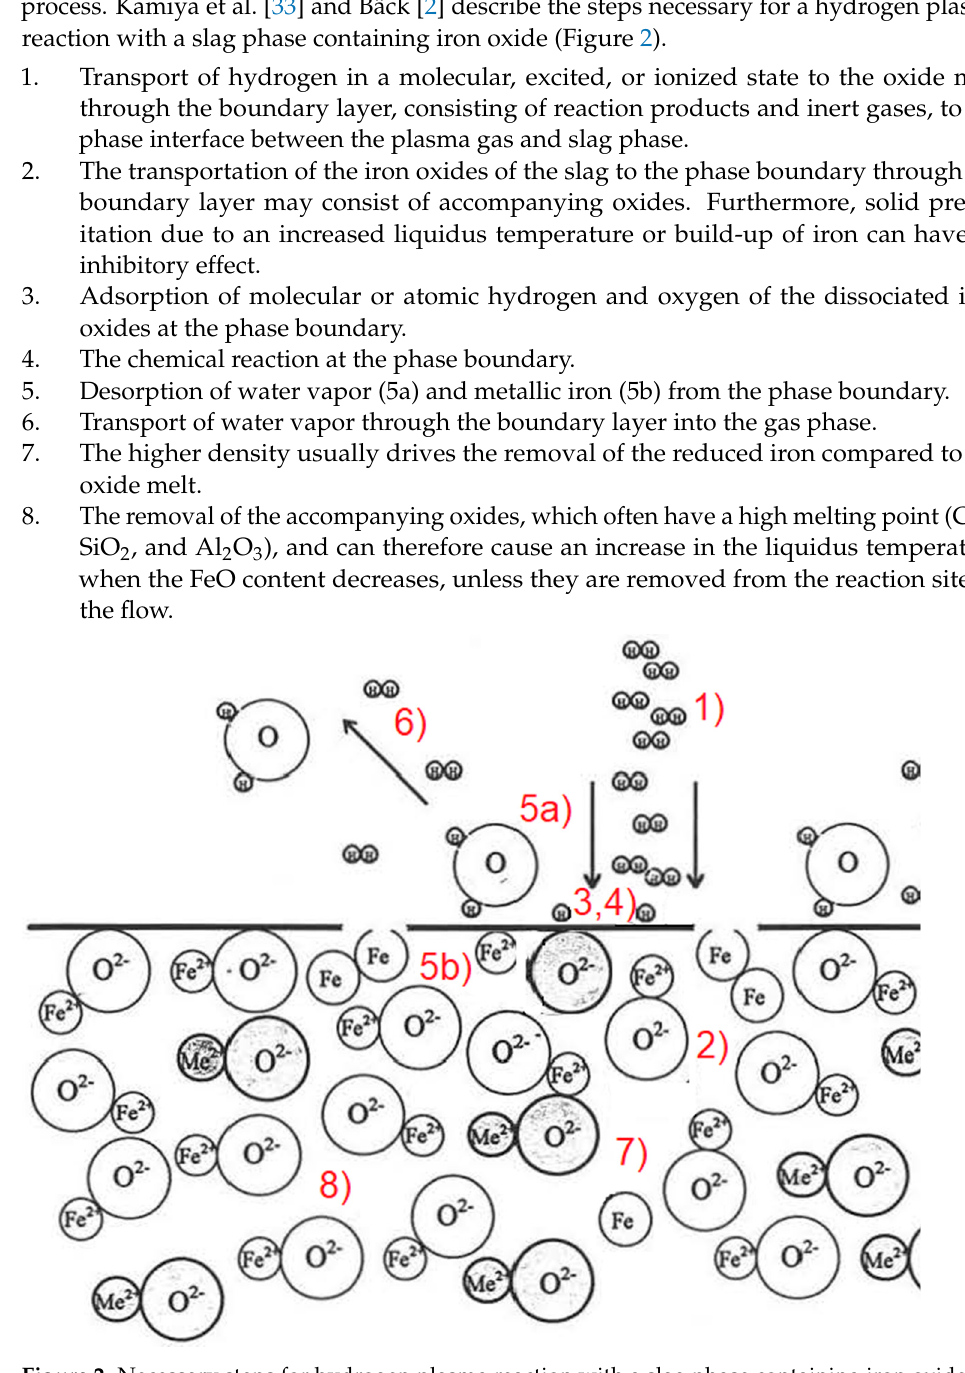
Figure 2. Necessary steps for hydrogen plasma reaction with a slag phase containing iron oxide [2]. According to the statements of Sormann [1], the chemical reactions for these steps are those listed in Equations